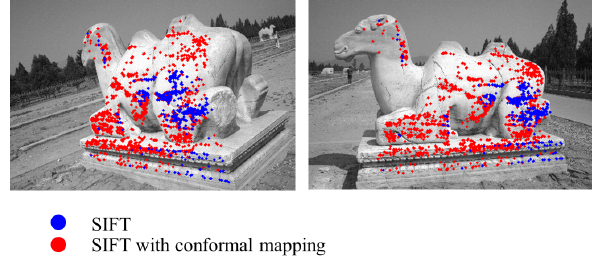
Figure 5: Comparison of the point matches obtained from SIFT (blue) and SIFT on conformal images (red). The figure is referred to (Soontranon,